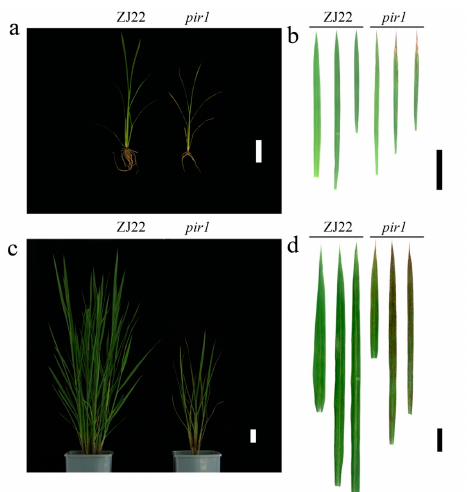
Figure 2. Comparison of the phenotypes of wild type ZJ22 and mutant pir1 . ( a), ( c ) Whole plants at five-leaf ( a ) or adult ( c ) stages: left, ZJ22, and right, pir1 . White scale bar = 5 cm. ( b) , ( d ) Leaf phenotype at five-leaf ( b ) or adult ( d ) stages: the three leaves on the left represent the flag leaf, the 2nd leaf (from the top) and the 3rd leaf of ZJ22; the three leaves on the right represent the flag leaf, the 2nd leaf, and the 3rd leaf of pir1 . Black scale bar = 2 cm. Trypan Blue (TB) assays confirmed that there was cell death in the lesions seen. Deep blue spots were present on the 2nd and especially the 3rd leaf of pir1 , while the flag leaf of pir1 and the sampled leaves of ZJ22 were almost uniformly light blue (Figure 3a). In microscopic section, the mesophyll cells of the 2nd and 3rd leaves of pir1 showed obvious damage and were remarkably stained blue in contrast to those of ZJ22 (Figure 3b,c). These results demonstrate conclusively that cell death occurred in the 2nd and 3rd leaves of pir1 .